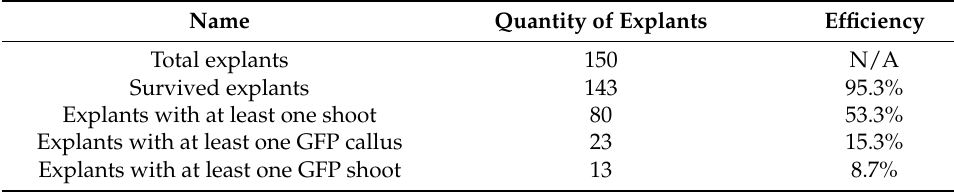
Table 1. Quantification of transformation efficiency during plant regeneration.